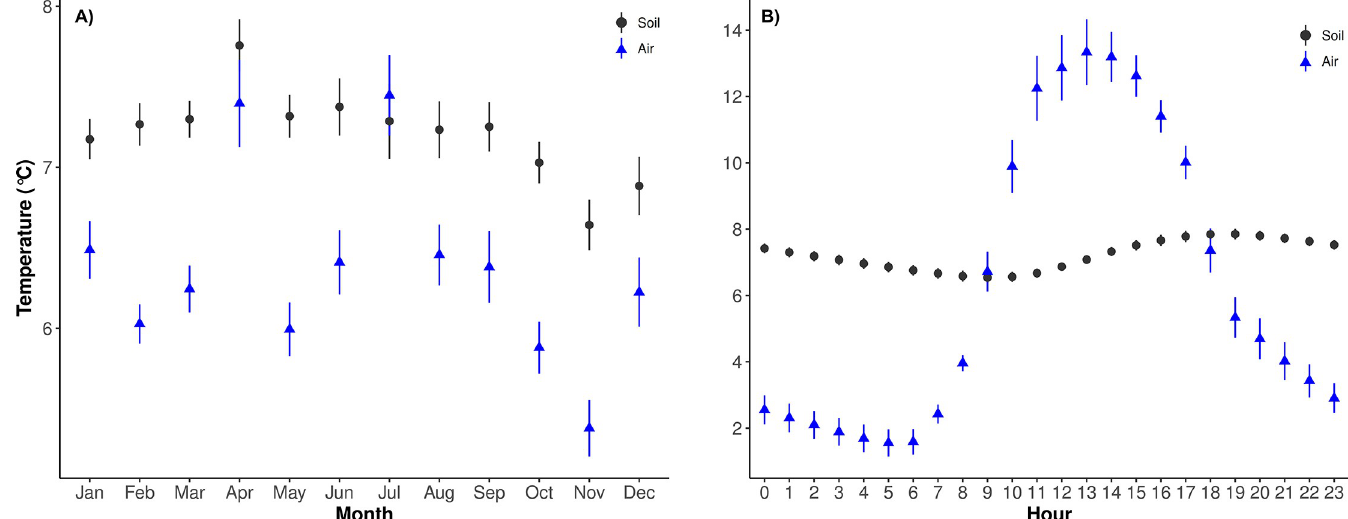
Fig 2. Mean monthly (A) and hourly (B) air (n = 9, blue arrows) and soil (n = 13, black dots) average temperature and mean standard errors for the period November 2013–October 2014. Data from I-button sensors installed in random plots along the